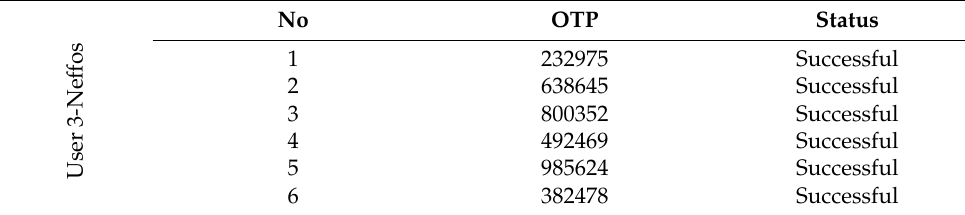
Table 5. The OTP results of the Neffos user.